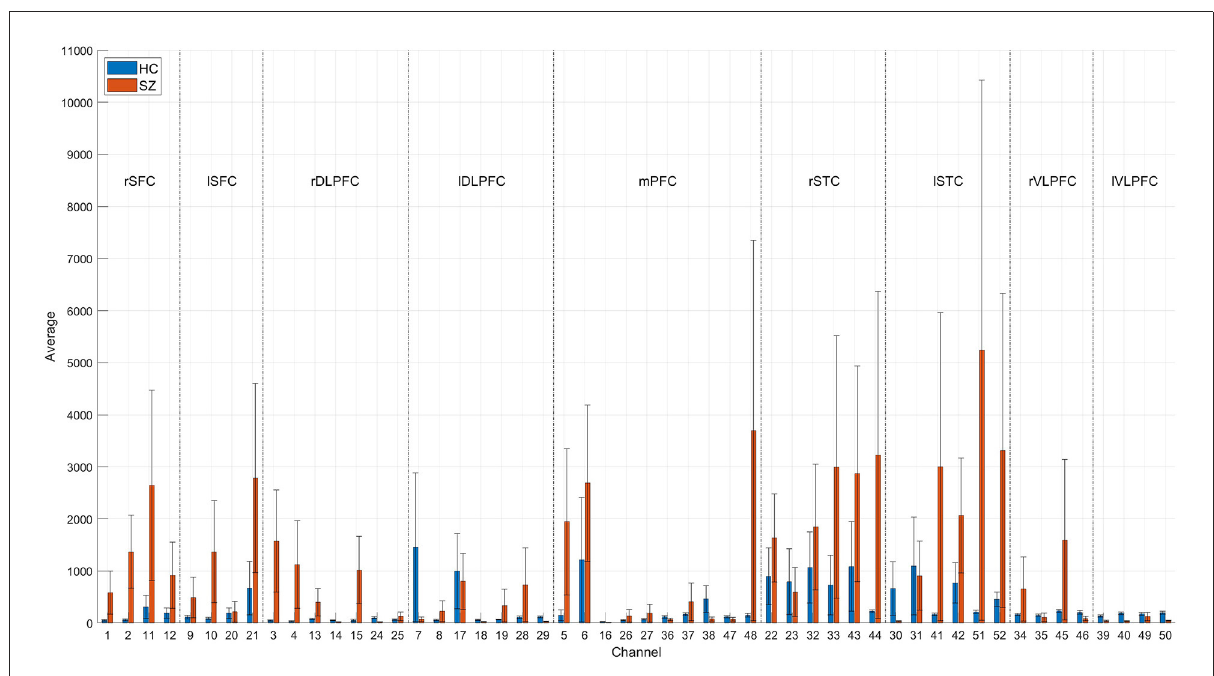
FIGURE10 Wavelet feature of 52 channels averaged for the HCs and SZs during the VFT, respectively. The error bars were drawn with standard errors.